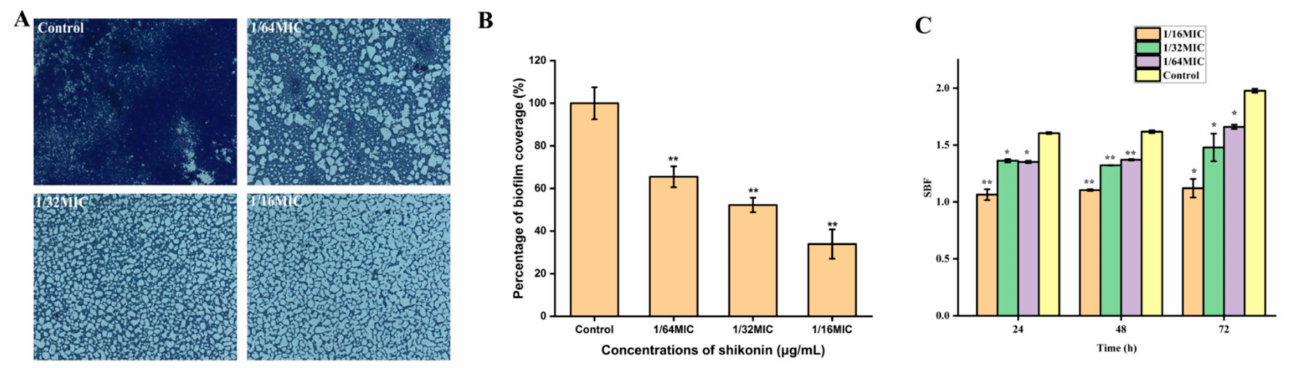
Figure 5. The effect of shikonin on biofilm formation of strain ATCC29213. ( A ) Observation of biofilm stained by crystals under optical microscope (400 × magnification); ( B ) The biofilm coverage rate was quantified with the software ImageJ; ( C ) The effect of different shikonin treatment time on the formation of biofilm. ** p < 0.01, * p <